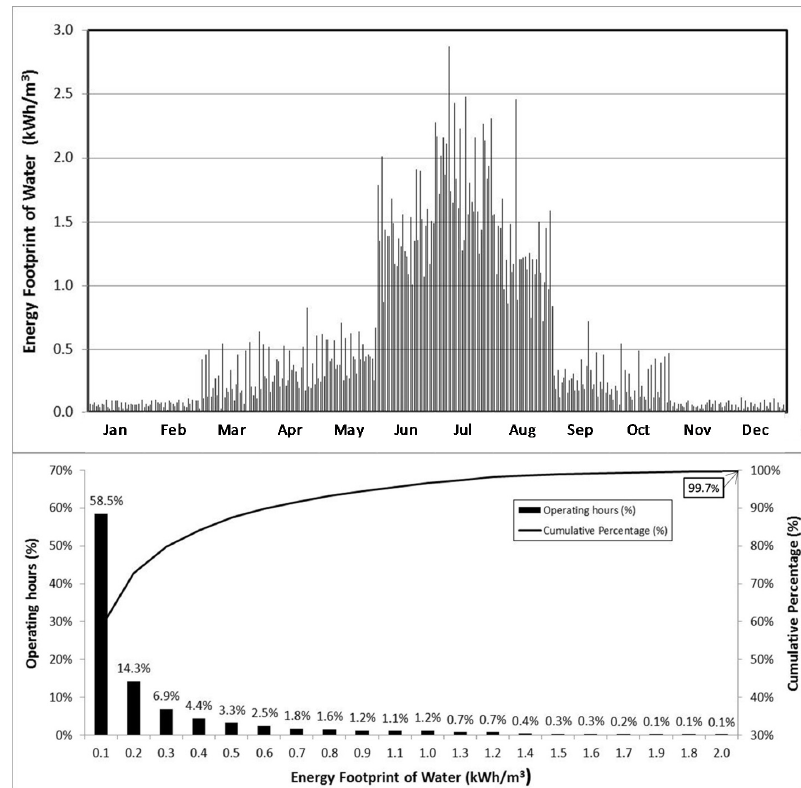
Figure 16. Network energy footprint of water.